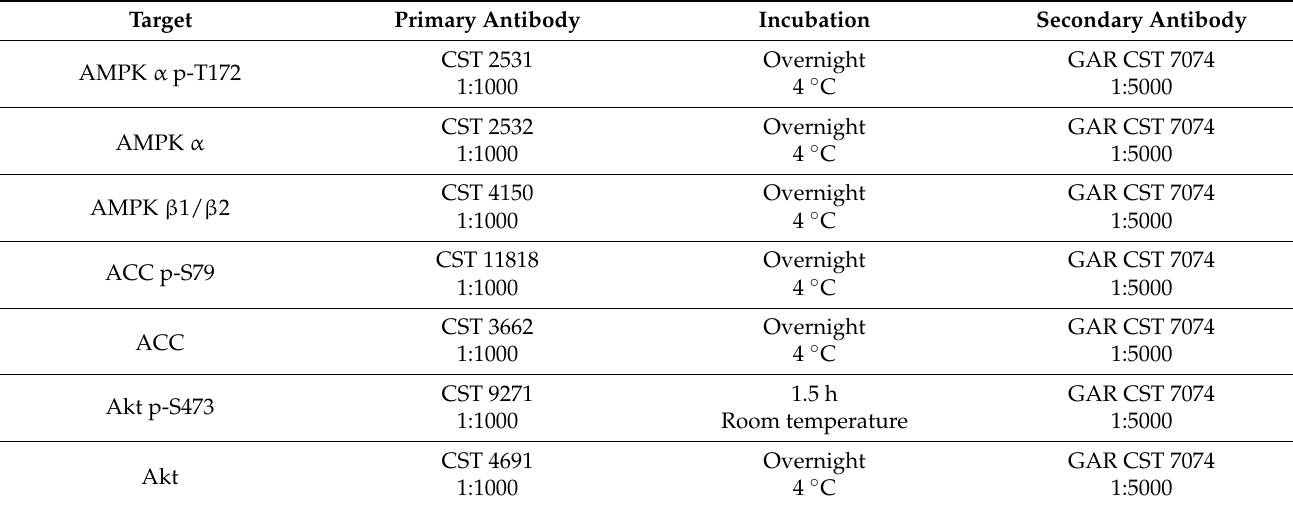
Table 2. Antibodies and protocols used for